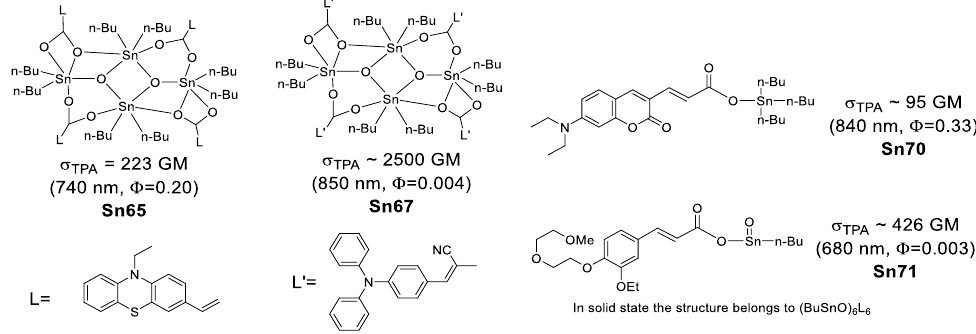
Figure 53. Some organostannoxanes with TPA properties.